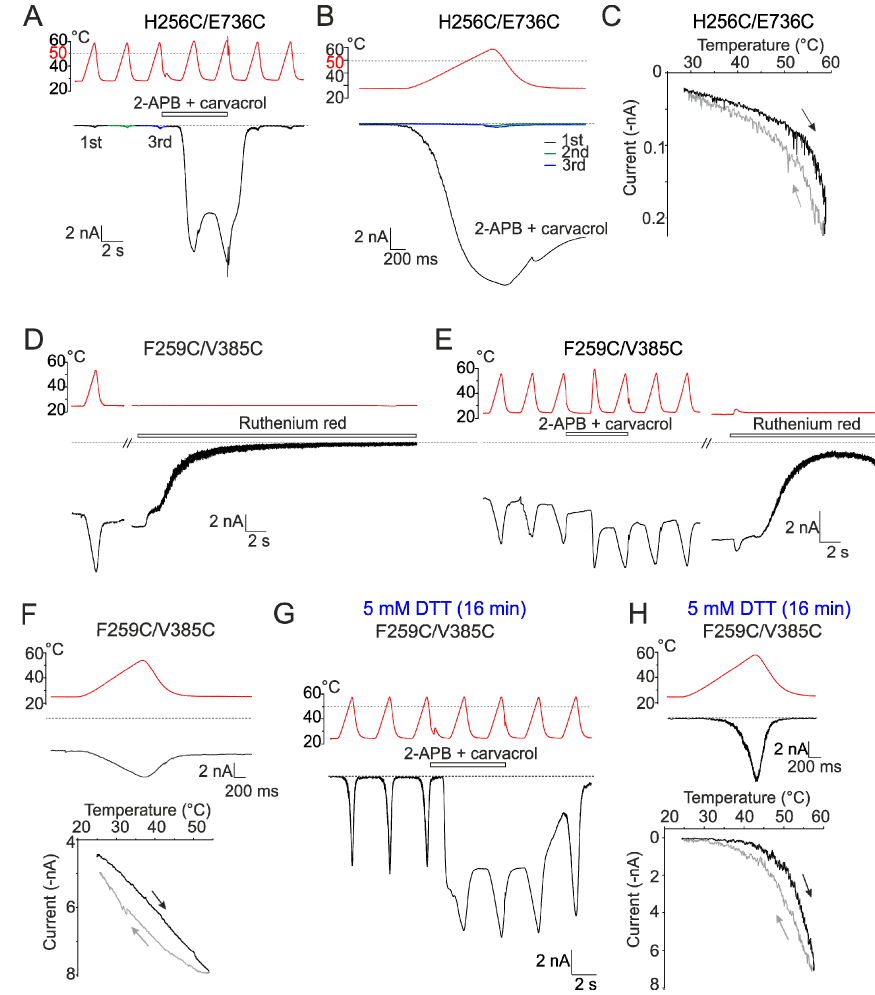
Figure 6. Disulfide locking experiments. ( A ) Representative whole-cell currents evoked by repetitive heat stimuli (shown above the records) recorded from HEK293T cell expressing the H256C/E736C double cysteine mutant channels. Currents were recorded in the absence or presence of mixed agonists (100 µM 2-APB + 100 µM carvacrol), as indicated by the horizontal bar above the records. Holding potential, − 70 mV. ( B ) Expanded traces from A. ( C ) Current–temperature relationship of the first heat response from the recording shown in A and B. ( D , E ) Representative whole-cell currents recorded at − 70 mV, evoked by heat stimuli, recorded from the indicated double cysteine mutants of TRPV3. The channels exhibited large basal currents that were fully blocked by ruthenium red (10 µM). The F259C/V385C double cysteine mutant exhibited strongly sensitized phenotype. ( F ) Expanded trace (top) and current-temperature relationship (bottom) of the first heat response shown in D. Notice a nonlinearity of the deactivation phase. ( G ) Representative F259C/V385C-mediated currents evoked by repetitive heat stimuli recorded from HEK293T cell pretreated with 5 mM dithiothreitol (DTT) for 16 min. ( H ) Expanded trace (top) and current–temperature relationship (bottom) of the first heat response shown in G.